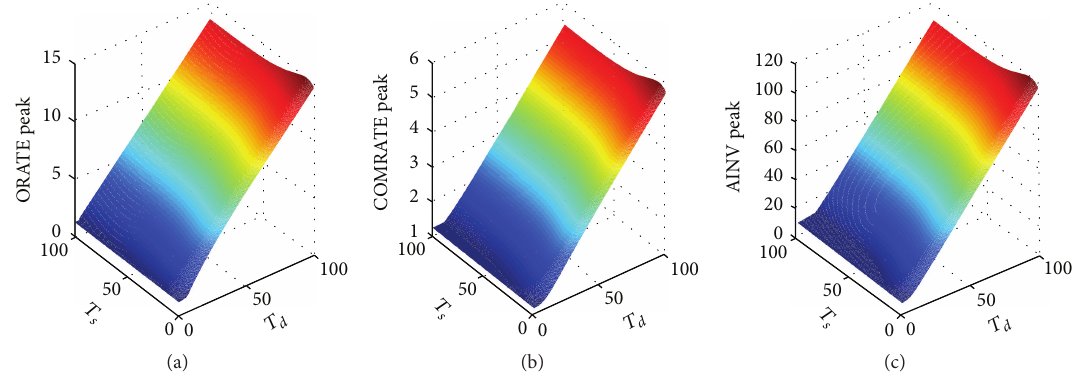
Figure 4: The impacts of 𝑇 𝑠 and 𝑇 𝑑 on the peak